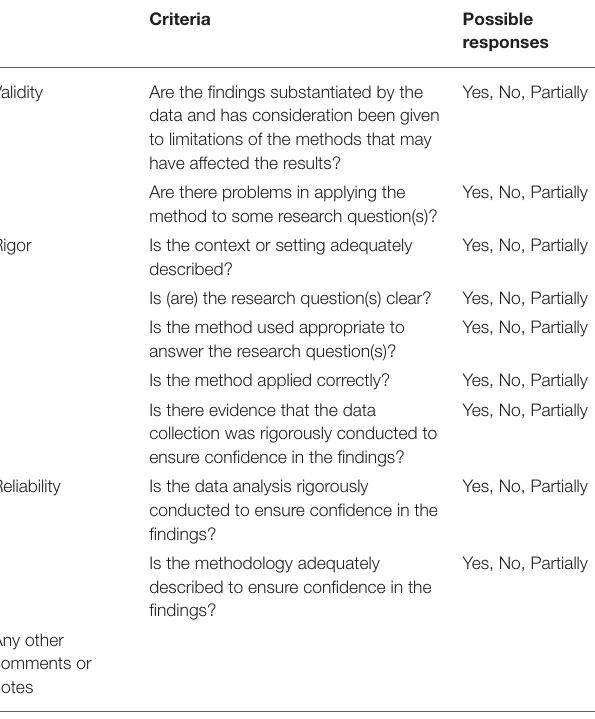
TABLE 1 | Reviewer template for considering paper focus. TABLE 2 | Reviewer template for considering paper quality [adapted from Béné et al., 2016].